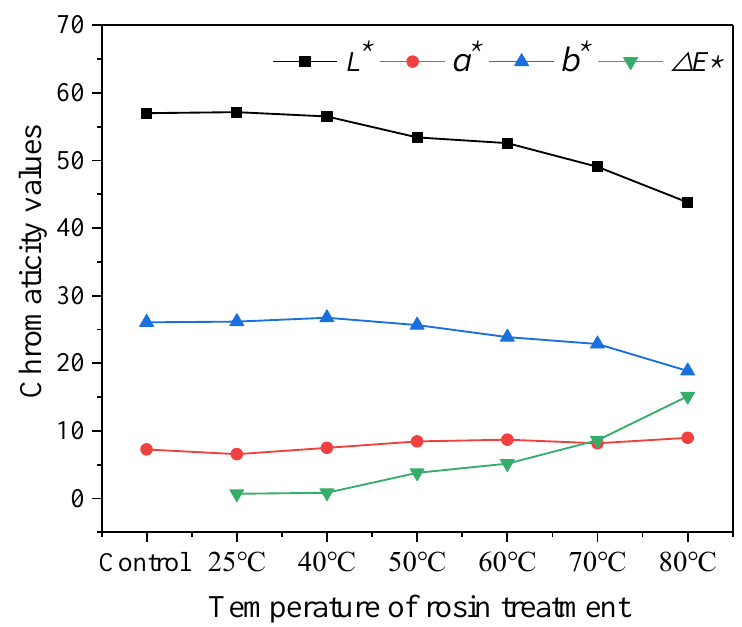
Figure 3. Chromaticity values of bamboo culm before and after the rosin treatment with different